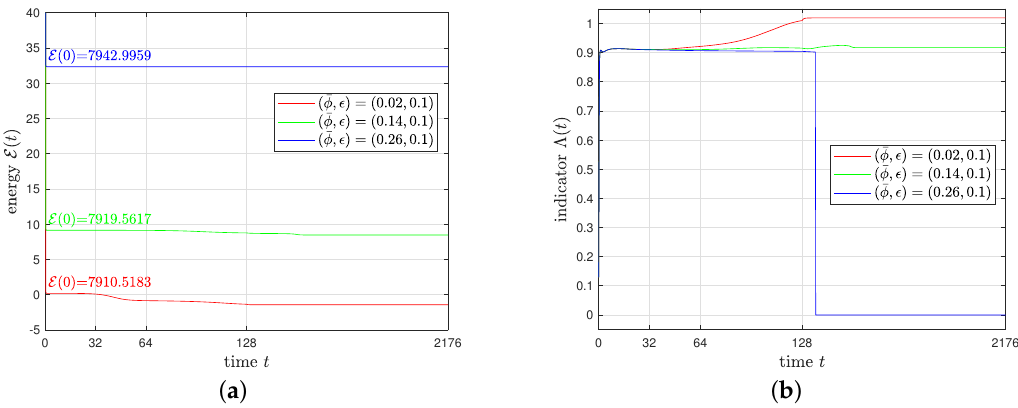
Figure 7. Evolutions of ( a )